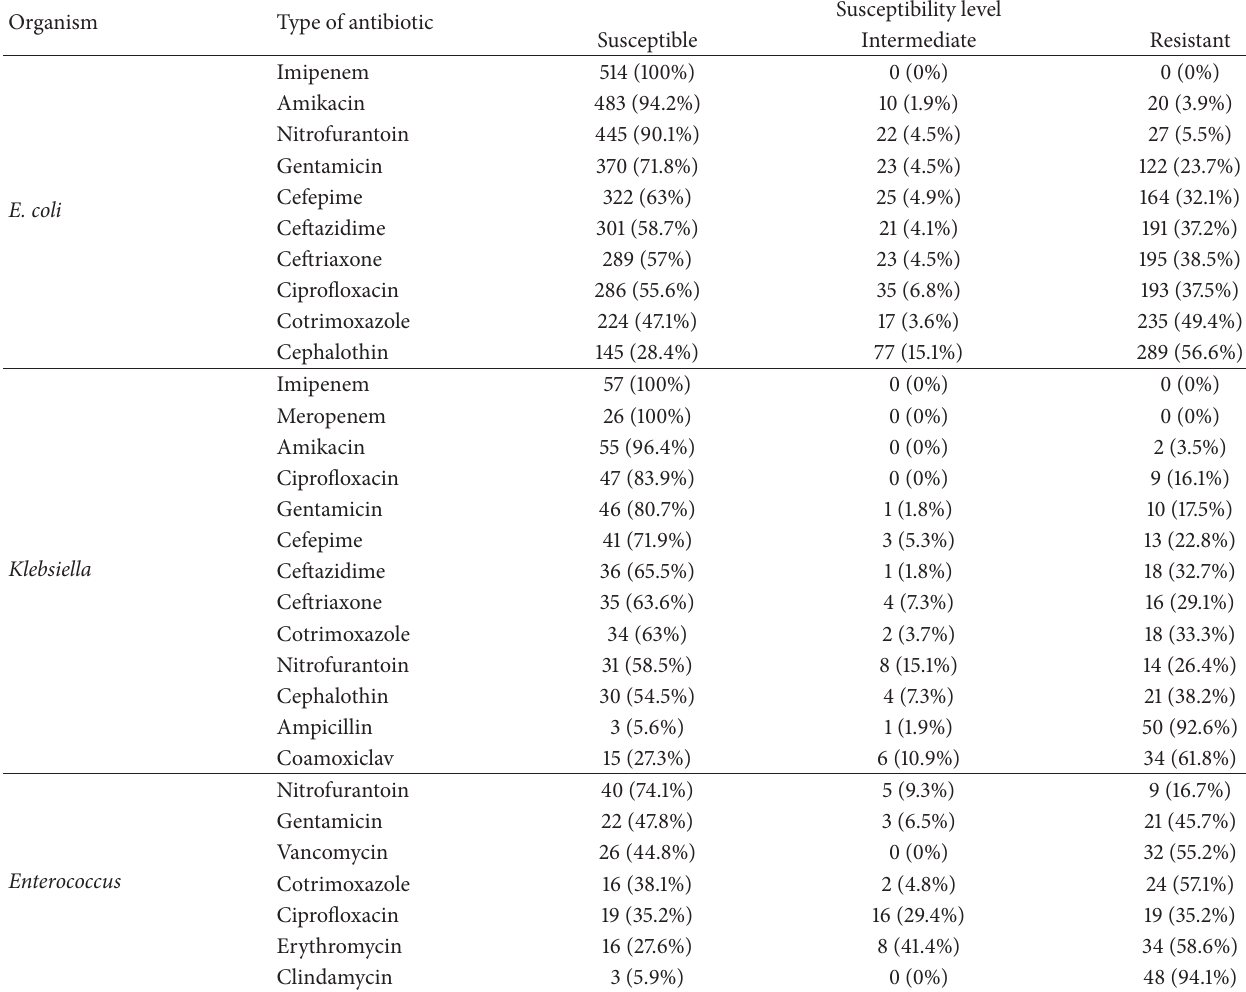
Table 3: Antimicrobial susceptibility pattern of isolated organisms from urine